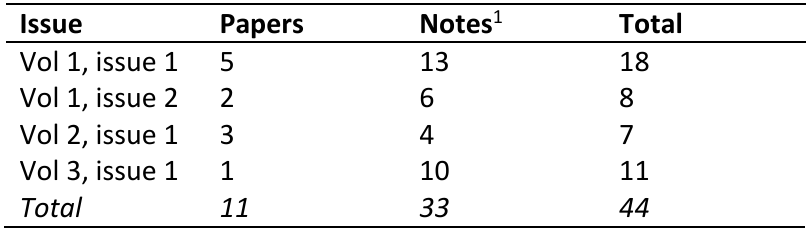
Table 1. JEHC types of contributions per